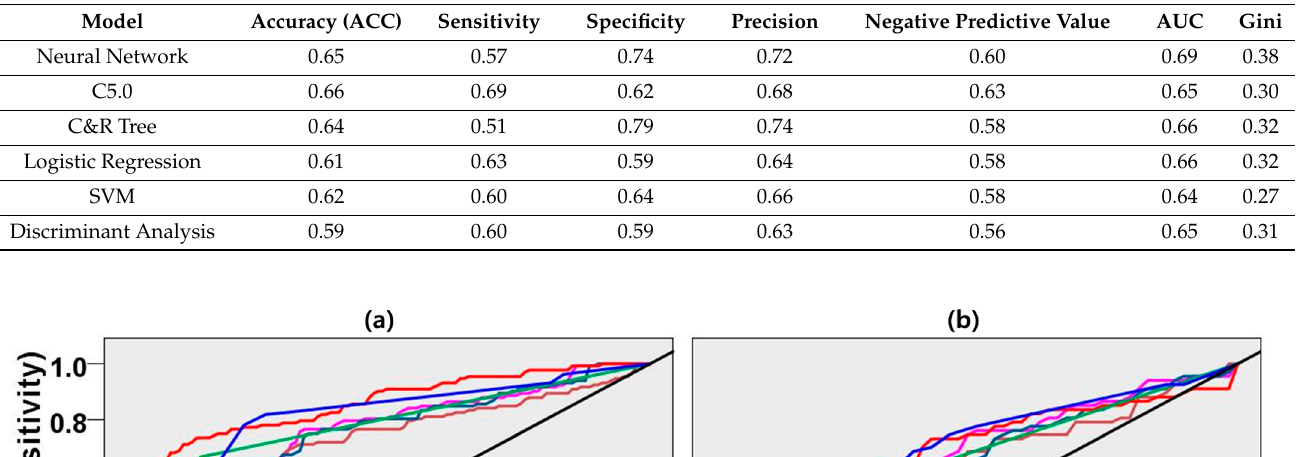
Table 3. Results of the classification performance of different models using the testing EMG dataset.